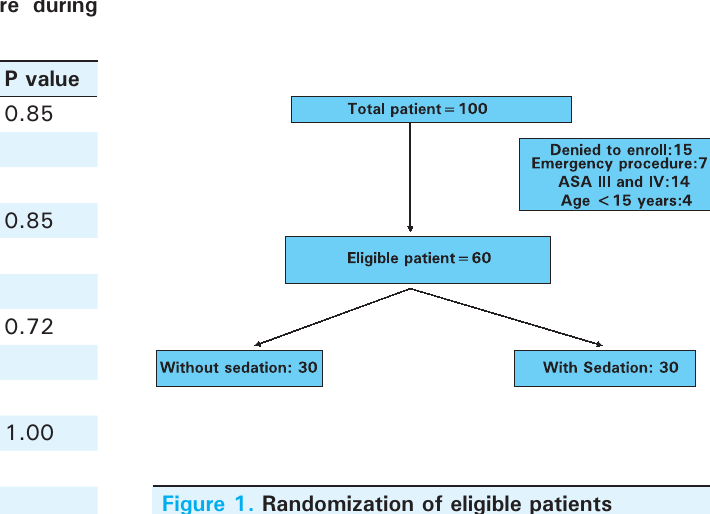
Figure 1. Randomization of eligible